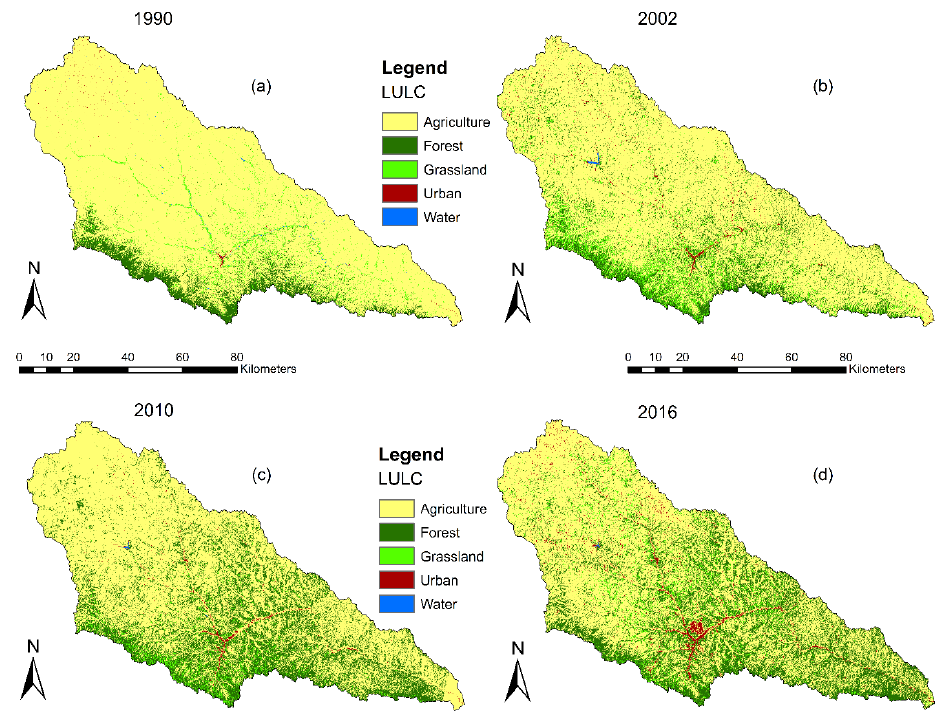
Figure 5. Land use land cover maps of the Yanhe catchment for ( a ) 1990, ( b ) 2002, ( c ) 2010 and ( d ) 2016. Table 2. The area percentage of land use land cover from 1990–2016 period in the Yanhe catchment. LULC Type